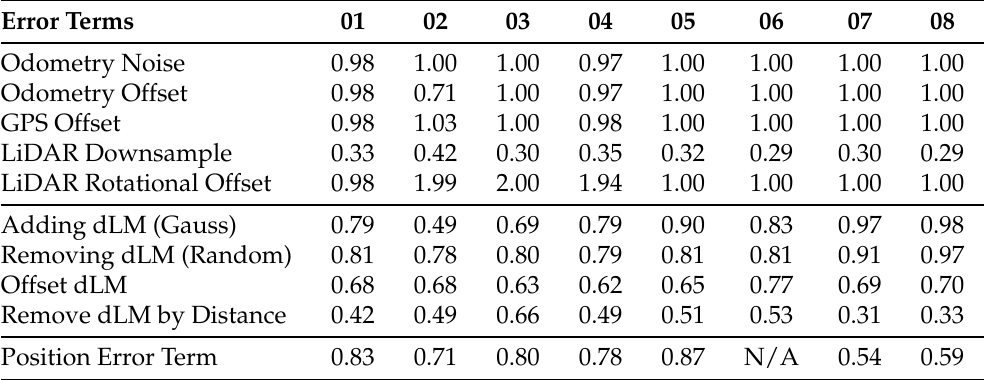
Table 4. Error terms for detection and matching measured over the baseline, nine perturbation injections over eight test drives. Values are avaraged over all three levels of severity s . The position error term for Test Drive 06 could not be retrieved.